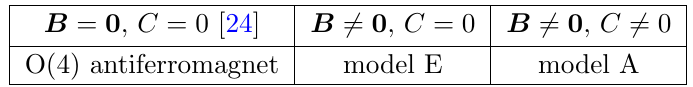
Table 1 . Summary of dynamic universality classes (massless two-(cid:13)avor